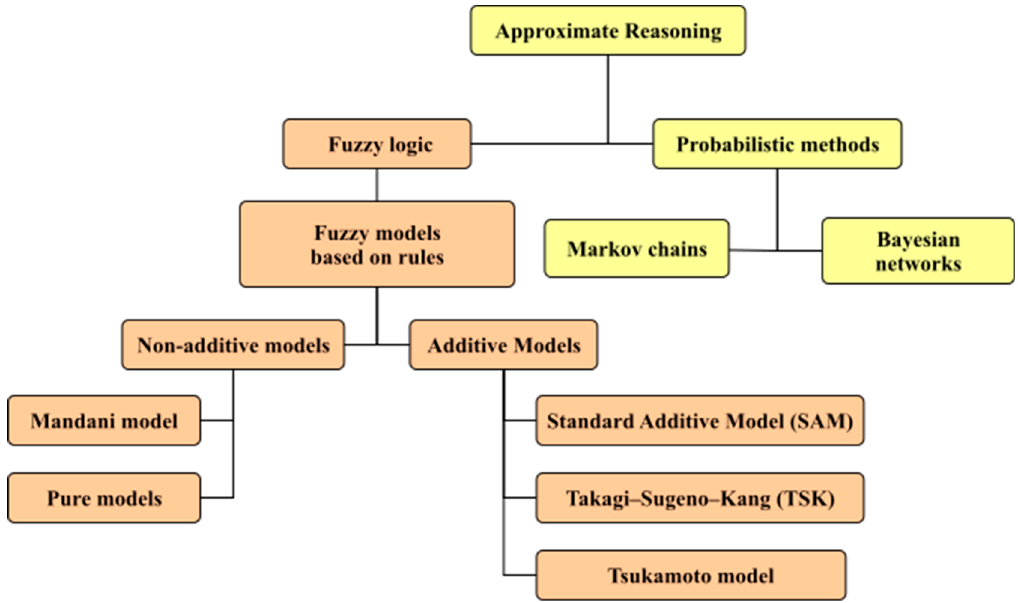
Figure 10. Approximate reasoning models. “Source [142,157–163], own elaboration”.